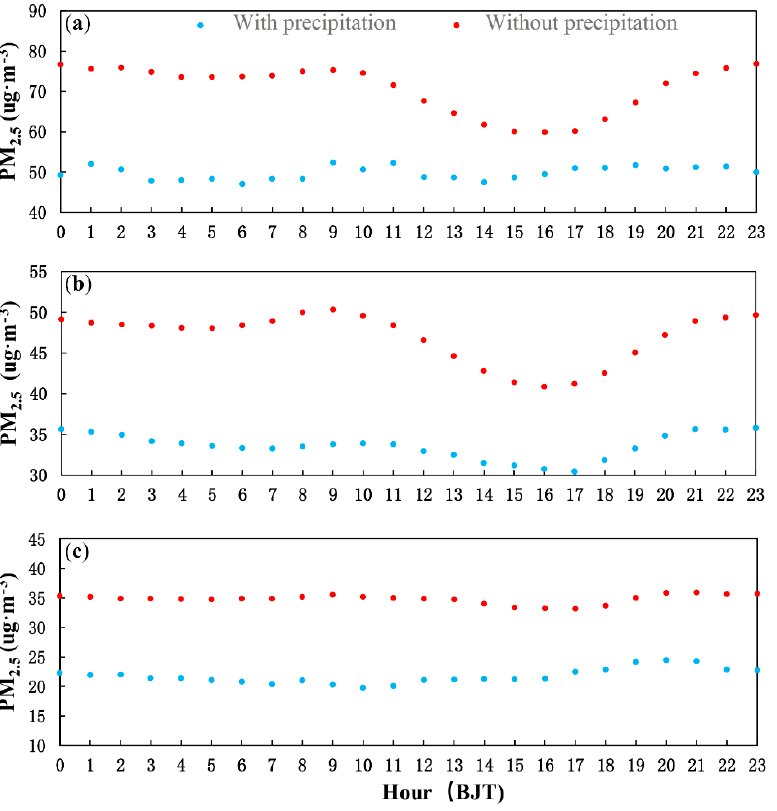
Figure 3. Diurnal variation of PM 2.5 mass concentration averaged for cases with and without precipitation during the period 2015–2017 over ( a ) BTH, ( b ) YRD, and ( c ) PRD regions. Note the time is Beijing time (BJT).